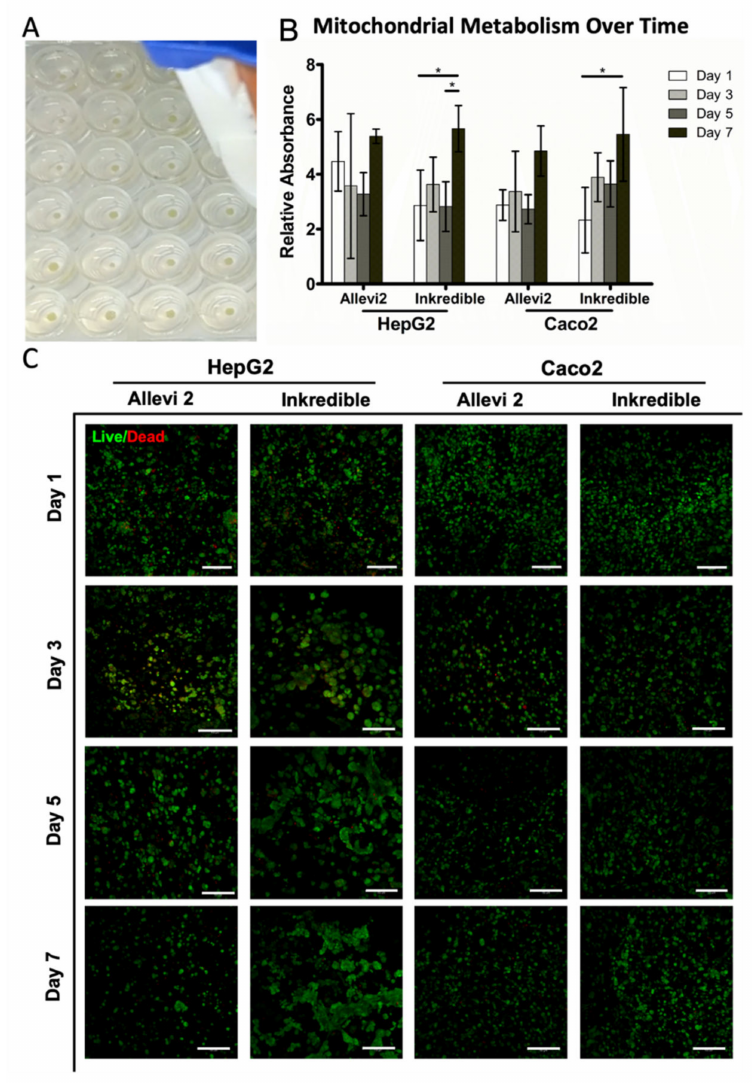
Figure 4. Metabolic activity and viability over time of organoids formed using HepG2 and Caco2 cells. ( A ) A representative image of more fine-tuned organoids (supplemented with gelatin) for visualization, in 96-well plates with greater consistency of geometry and size. ( B ) Quantification of mitochondrial metabolism using (3-(4,5-dimethylthiazol-2-yl)- 5-(3-carboxymethoxyphenyl)-2-(4-sulfophenyl)-2H-tetrazolium)(MTS)assays. Thehigherthemetabolic activity, the higher the quantity of cells. Significance: * p < 0.05. ( C ) Live / dead staining of organoids over time, showing a high prevalence of viable cells. Green—calcein AM-stained viable cells; red—ethidium homodimer-1-stained dead cells. Scale bar = 150 µ